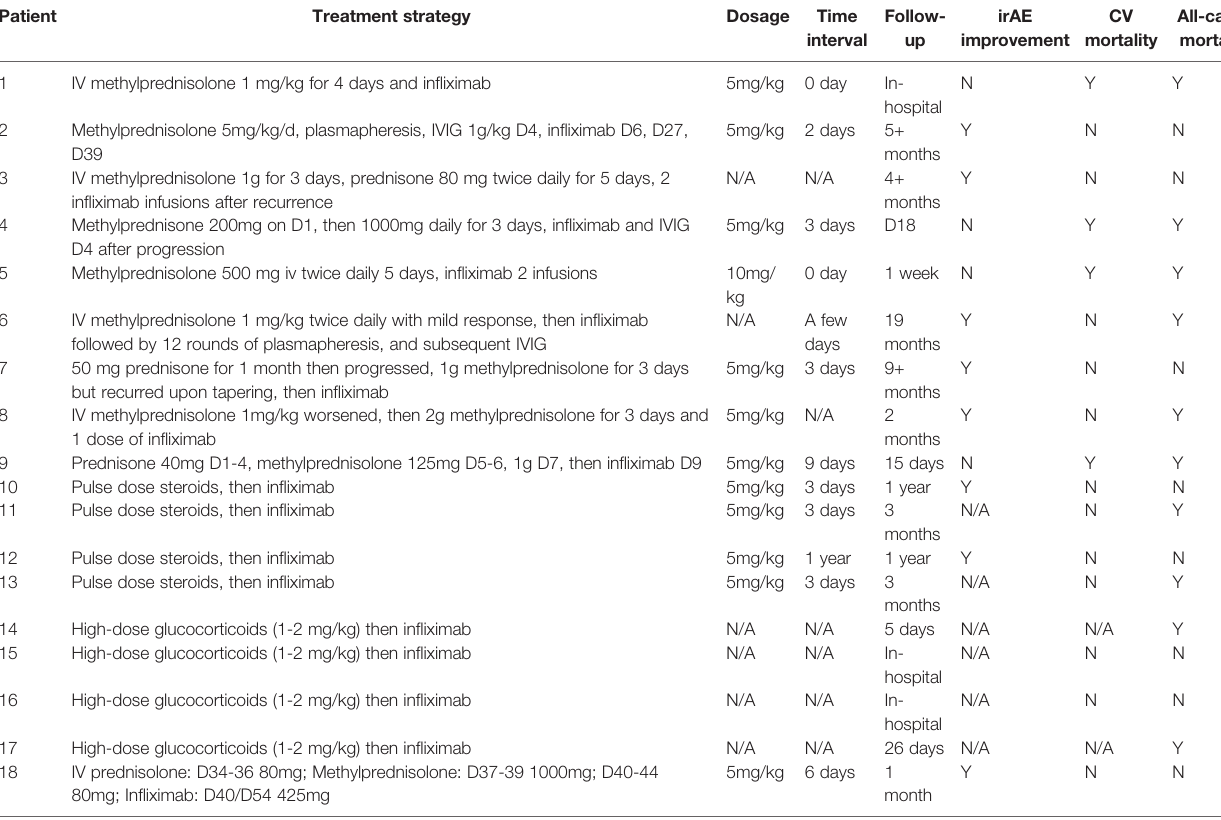
TABLE 2 | Treatment strategies and outcomes in in fl iximab treated ICI-induced myocarditis patients. Patient Treatment